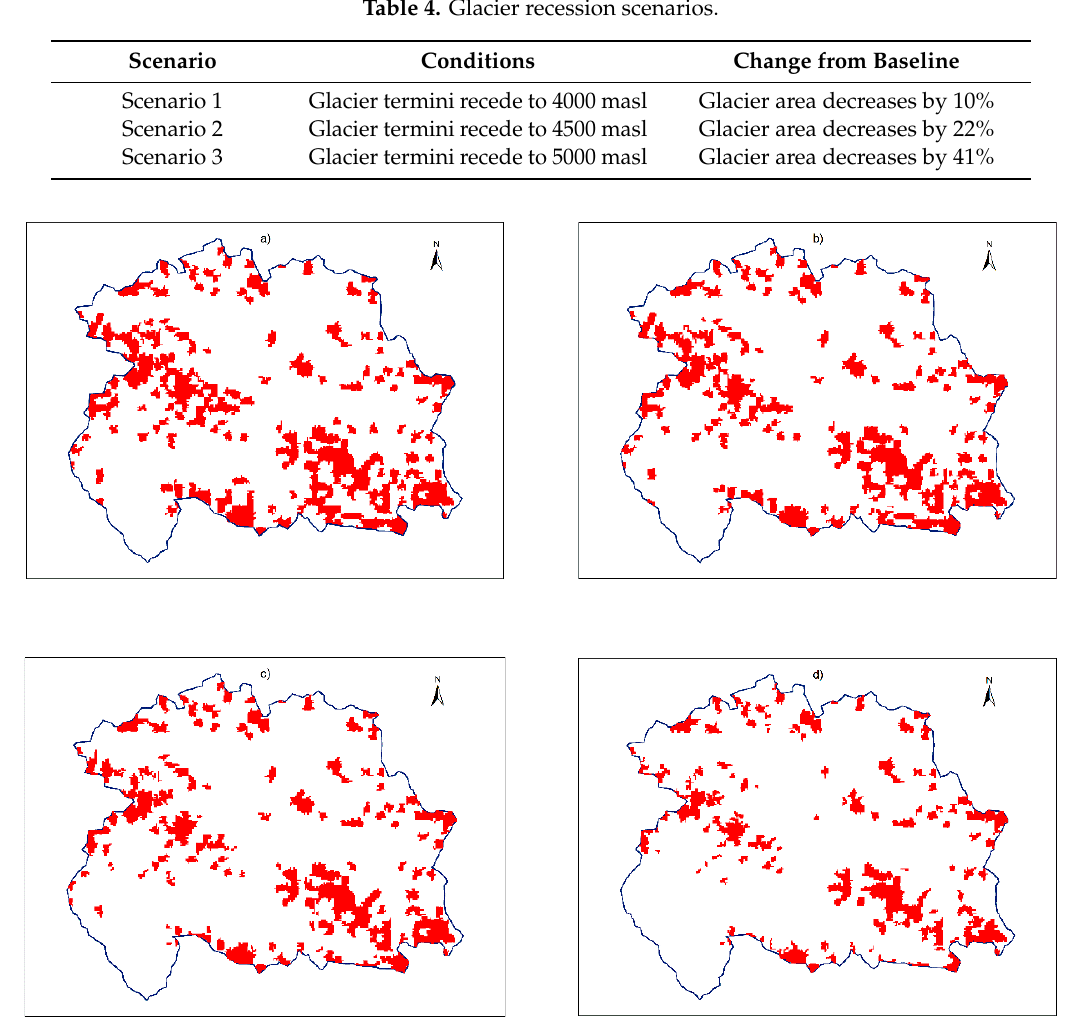
Figure 3. Glacier coverage of the Hunza basin under different scenarios: ( a ) baseline with no recession; ( b ) recession to 4000 masl; ( c ) recession to 4500 masl; ( d ) recession to 5000 masl.